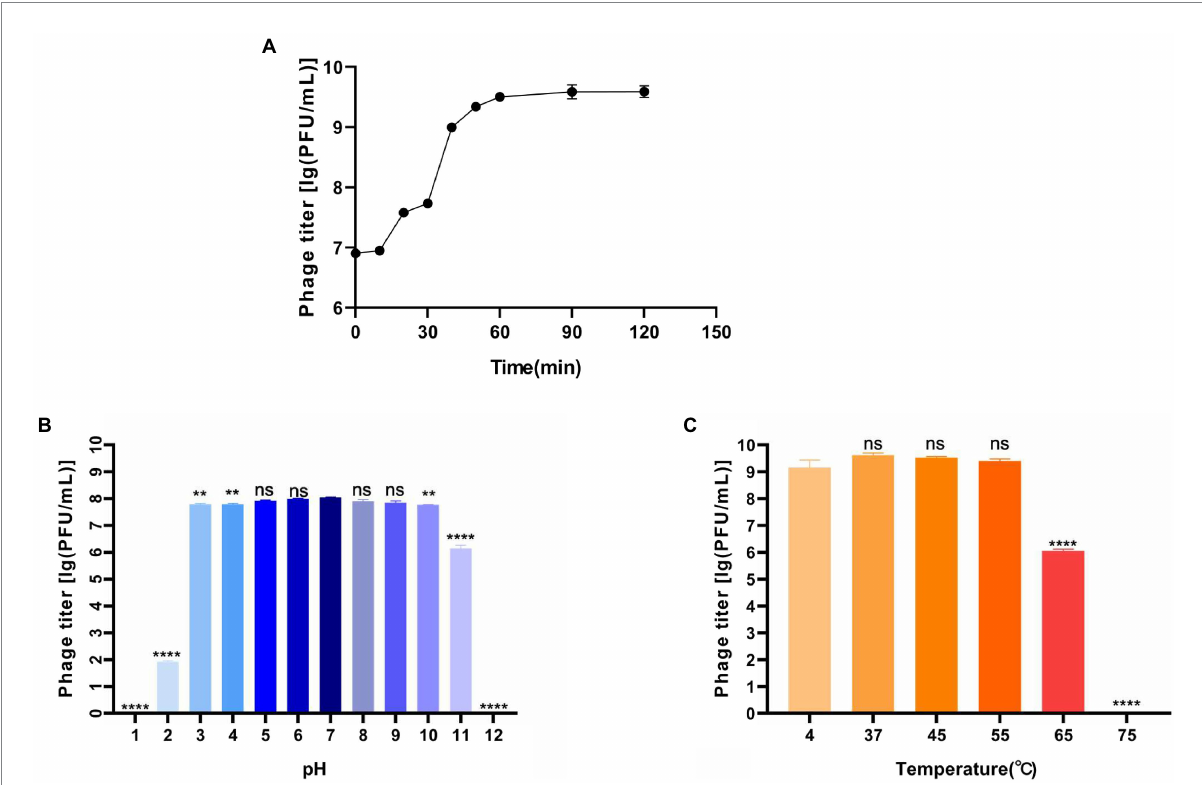
FIGURE 2 Biological characteristics of phage BUCT609. (A) One-step growth curve. The latent period of the phage was about 10 min, and the burst period of the phage was the following 60 min. And after 70 min, the phage grew into the plateau phase. The data is the average of three parallel experiments. Two bars above and below each point represent the standard deviation of the results of three parallel experiments. (B) Thermal stability. Phage titer of BUCT609 after incubation for 1 h at different temperatures. The data is the average of three replicates. There was no significant difference in the titer between 4 and 55 ° C. At 65 and 75 ° C, its titer decreased significantly ( p < 0.0001) compared with that at 4 ° C. (C) pH sensitivity. Phage titer of BUCT609 after incubation at various pH values at 37 ° C for 1 h. The data is the average of three replicates. There was no significant difference in the titer from pH 5 to 9. Compared with the titer at pH 7, its titer decreased slightly ( p < 0.01) at pH 3, 4, and 10 and decreased significantly ( p < 0.0001) at pH 1, 2, 11, and 12. There is no significant difference between the two groups of data when p < 0.5, which was showed as ns in the figure. The bar above column represents the standard deviation of the results of three parallel